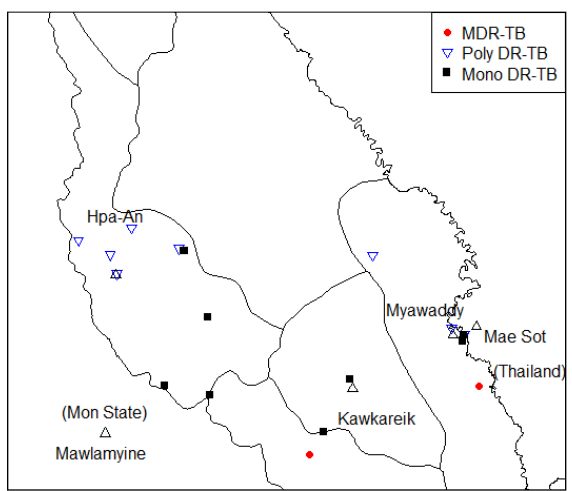
Figure 4 . Geographic distribution of drug-resistant TB patients. Figure 4. Geographic distribution of drug-resistant TB